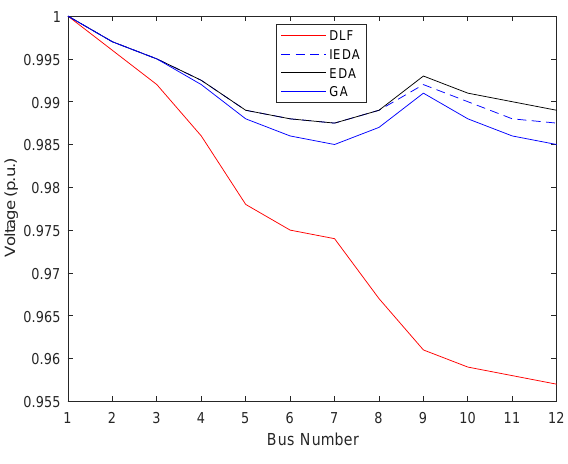
Figure 5. Voltage distribution of the 12 bus radial distribution system.